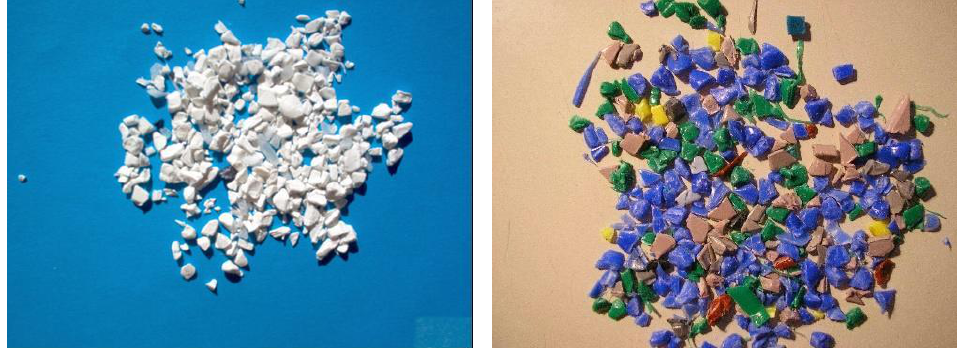
Figure 1. Industrial wastes from PP ( left ) and HDPE ( right ).